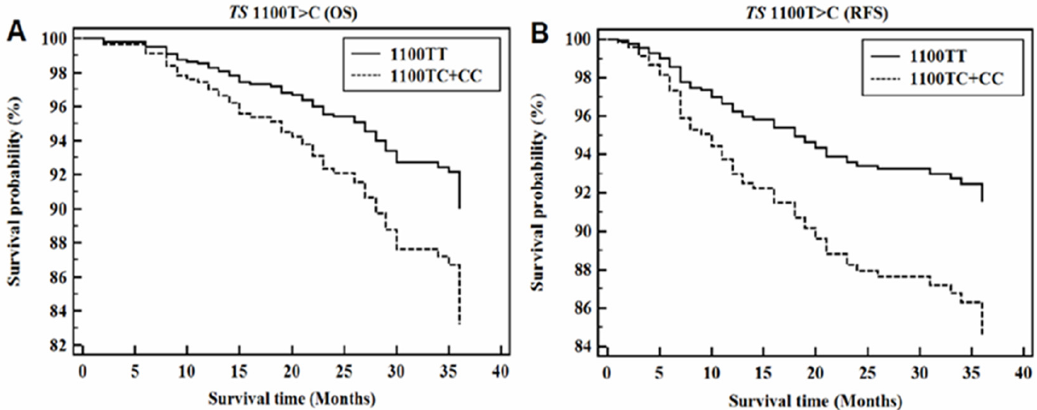
Figure 1. Cox proportional-hazard regression analysis for TS 1100T>C. ( A ) Overall survival (OS) curve for TS 1100T>C (Dominant model; AHR = 1.82; 95% CI = 1.07–3.08; p = 0.027). ( B ) Relapse-free survival (RFS) curve for TS 1100T>C (Dominant model; AHR = 2.00; 95% CI = 1.19–3.35; p = 0.009).